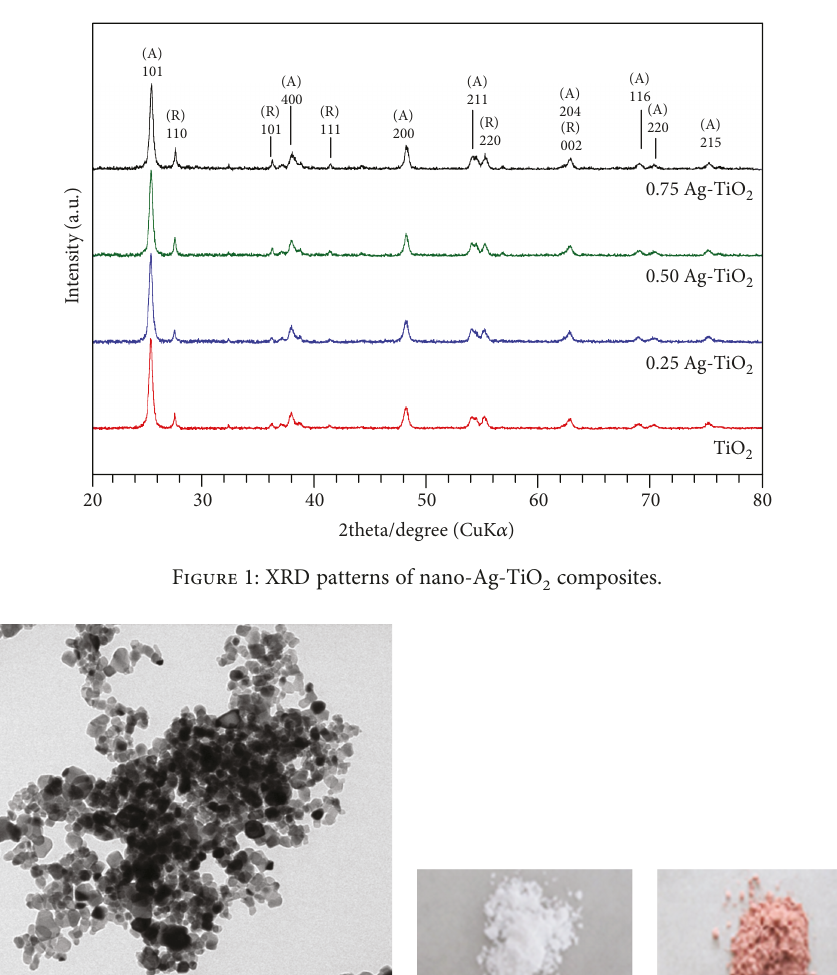
composite. Digital photo of TiO 2